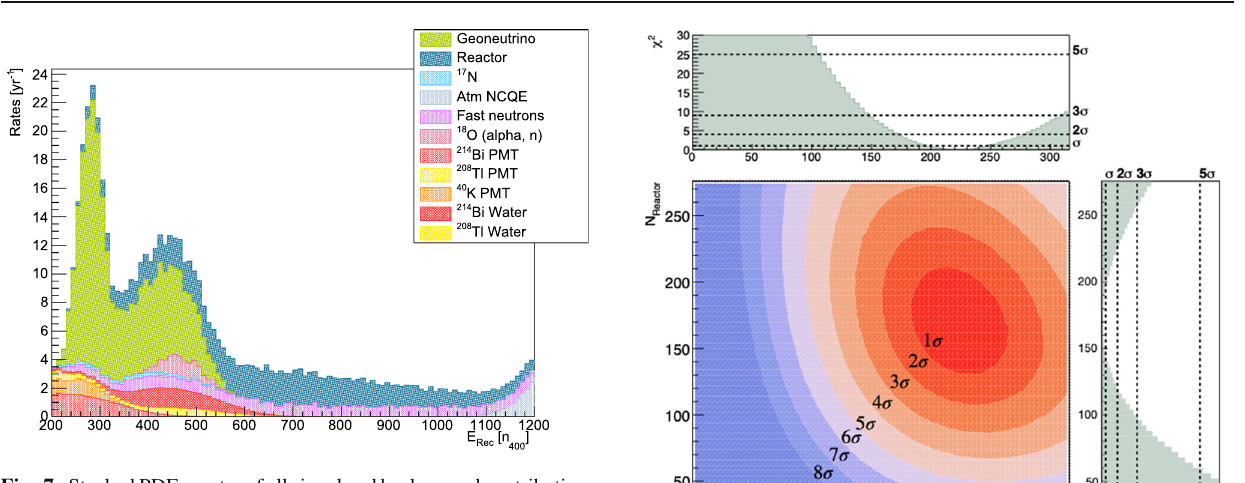
year of data taking. These significances do not include any